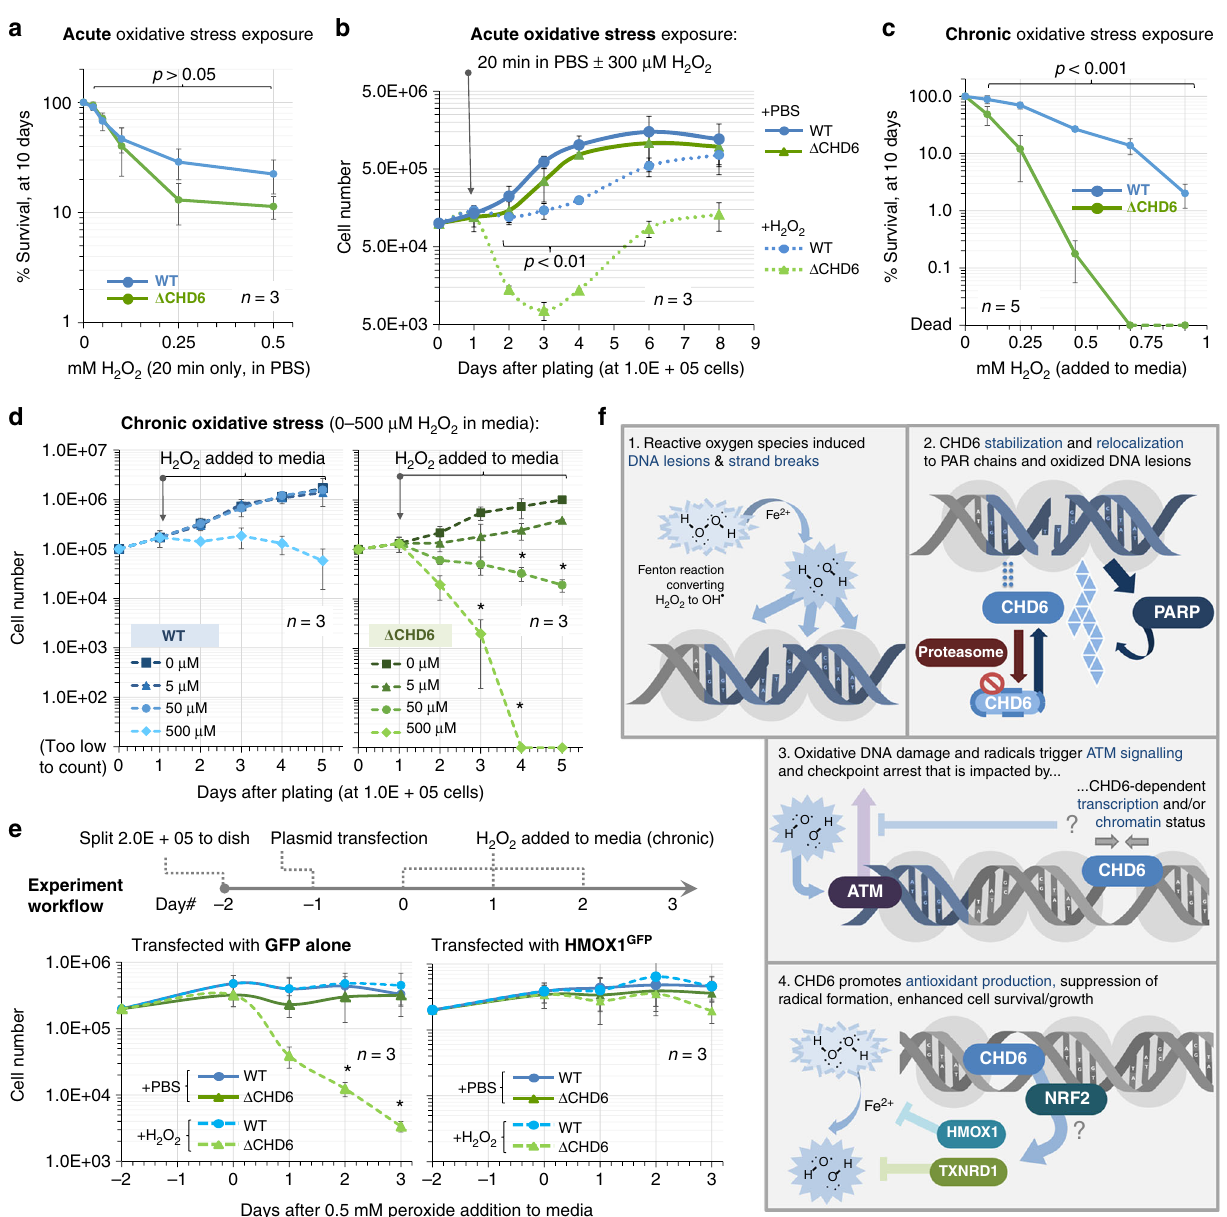
Fig. 7 CHD6 loss causes failure to thrive after oxidative stress and perturbed oxidative base excision repair initiation. a WT and A549 Δ CHD6 cells were exposed to H 2 O 2 in PBS for 20 min, washed, plated and scored for colony formation 10 days later. Error bars = s.e.m.; n = 3; P value determined by two-way ANOVA. b The 1.0E + 05 WT and A549 Δ CHD6 were plated and, 24 h later, exposed to ±300 µ M H 2 O 2 in PBS for 20 min, washed and returned to media for 8 days. Viable cells were counted daily. Error bars = s.e.m.; n = 3. P values represent unpaired t -test between WT and A549 Δ CHD6 at indicated time points. c The 300× WT and A549 Δ CHD6 cells were exposed to H 2 O 2 in media for 48 h, plated and scored for colony formation 10 days later. Error bars = s.e.m.; n = 5; P value determined by two-way ANOVA. d The 1.0E + 05 WT and A549 Δ CHD6 were plated and, 24 h later, 0 – 500 µ M H 2 O 2 was added to media. Fresh H 2 O 2 was added daily to maintain chronic exposure. Cells were analyzed as in ( b ). Error bars = s.e.m.; n = 3. e WT and A549 Δ CHD6 were seeded at 2.0E + 05 and, 24 h later, transfected with either GFP or HMOX1 GFP . After 24 h, cells were exposed to 500 µ M H 2 O 2 in media and counted as in ( d ). For unpaired t -test at indicated points relative to 0 µ M H 2 O 2 control; * p < 0.05. In all cases, ±refers to with and without, blue refers to WT cells; green refers to Δ CHD6 cells. f A model for CHD6 function. (1) ROS such as hydroxyl radicals react with DNA to produce oxidative damage. (2) Oxidative stress suppresses proteasomal degradation of CHD6, stabilizing protein levels, while oxidative DNA breaks elicit PARP enzyme activation, generating PAR polymers in the vicinity of DNA lesions that enable CHD6 relocalization to oxidative DNA lesions. (3) CHD6 contributes to nucleosome compaction and transcriptional responses, which potentially modulate the magnitude of ATM-dependent signaling. (4) CHD6 promotes oxidative stress transcriptional responses (potentially via Nrf2) and, as a consequence, antioxidant proteins such as HMOX1 and TXNRD1 suppress oxidative stress and DNA